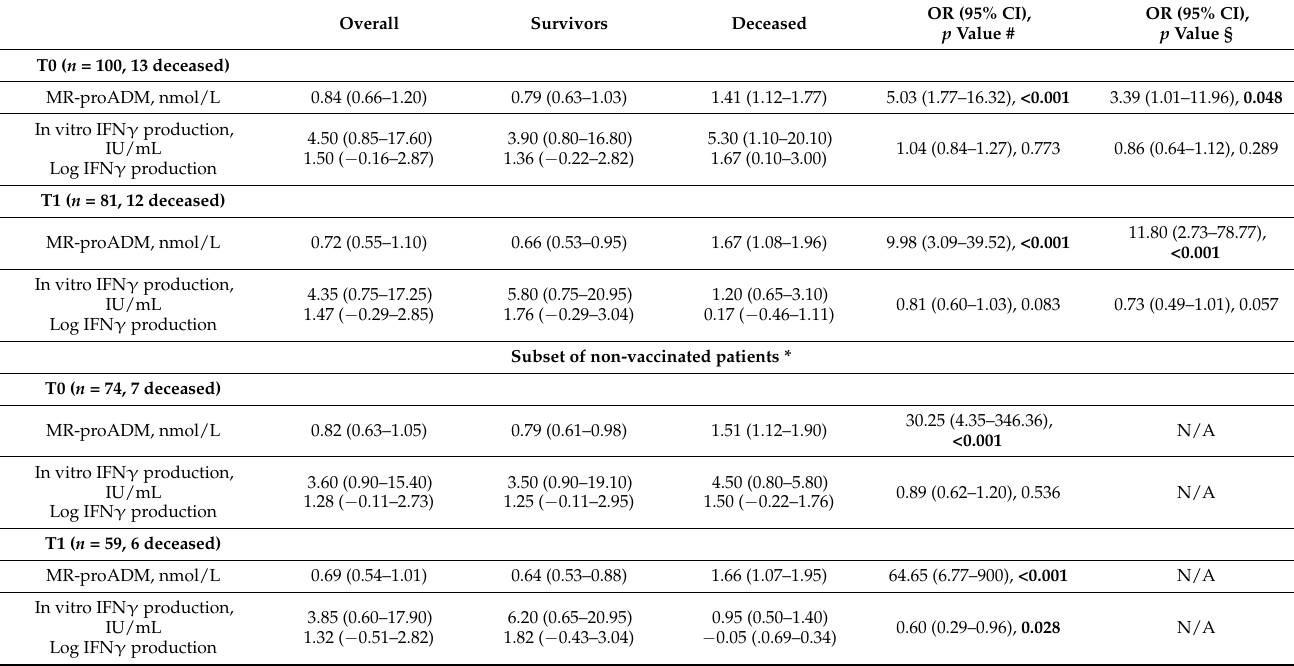
Table 2. Association between MR-proADM and in vitro IFN γ production and in-hospital mortality, at admission (T0) and after 7 days of hospitalization